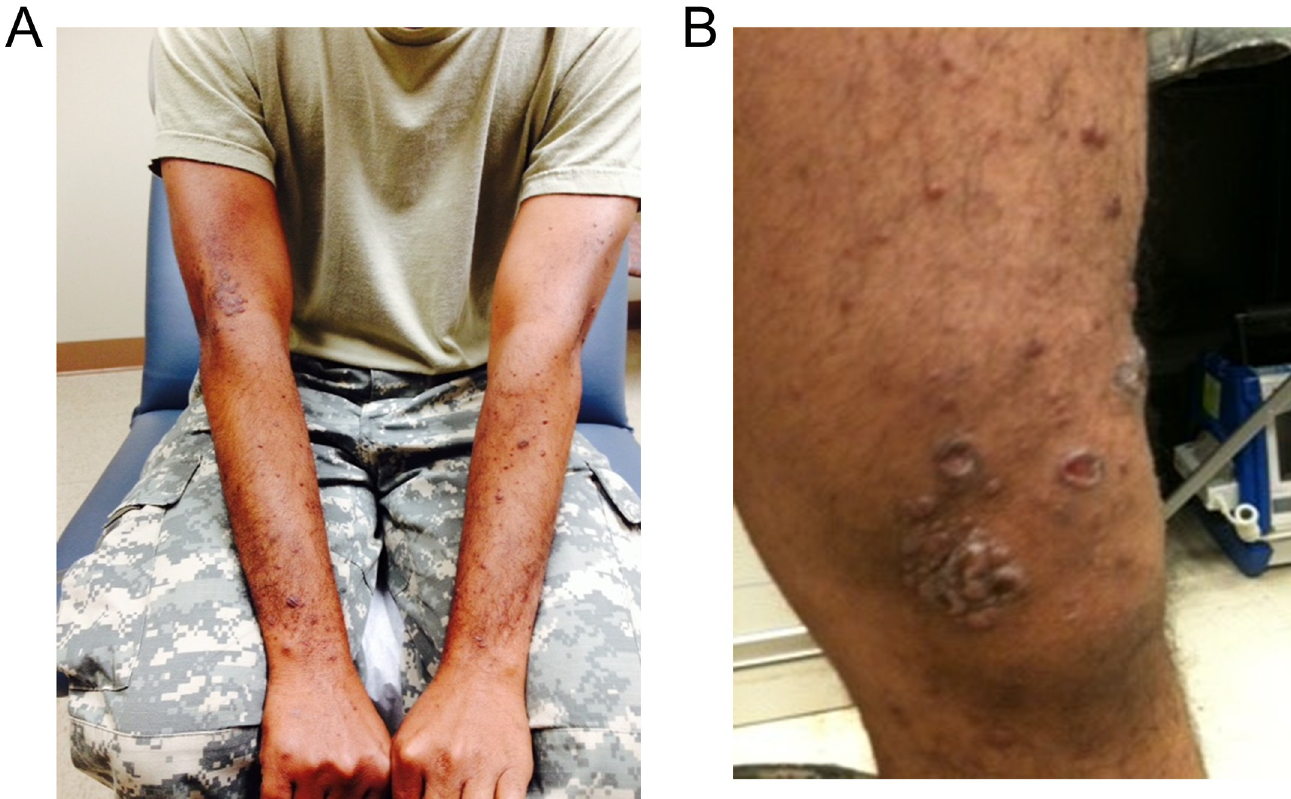
Fig 1. Erythema nodosum leprosum (ENL) manifesting as painful, erythematous lesions on patient’s forearms (a) and left knee (b) 24 months into initial treatment course. Lesions resolved with thalidomide treatment but returned upon cessation of therapy.